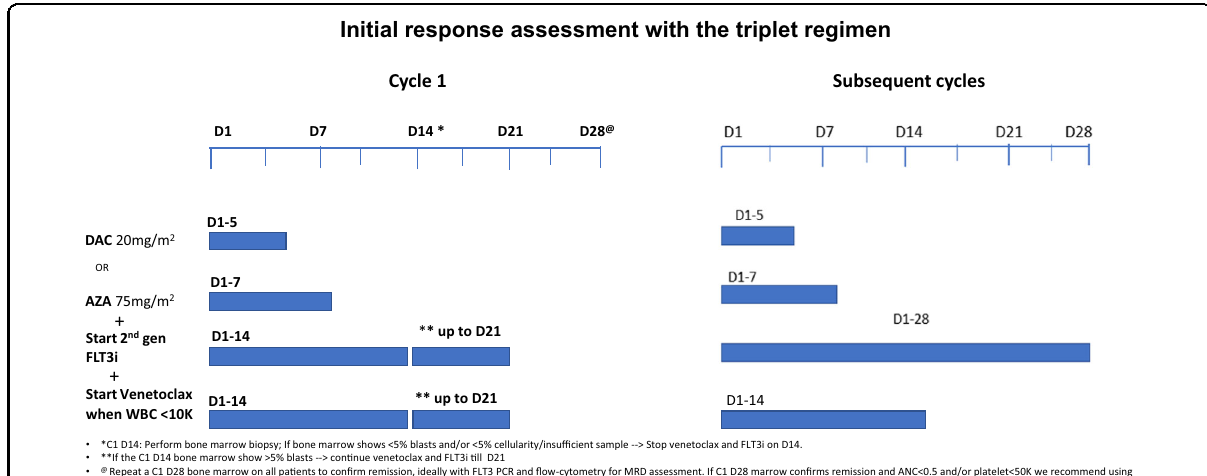
Fig. 3 Initial response assessment with the triplet regimen. *C1 D14: Perform bone marrow biopsy; if bone marrow shows <5% blasts and/or <5% cellularity/insuf fi cient sample → Stop venetoclax and FLT3i on D14. **If the C1 D14 bone marrow show >5% blasts → continue venetoclax, FLT3i till D21. @ Repeat a C1 D28 bone marrow on all patients to con fi rm remission . If C1 D28 marrow con fi rms remission and ANC<0.5 and/or platelet < 50K consider interrupting FLT3i and using neupogen to enhance count